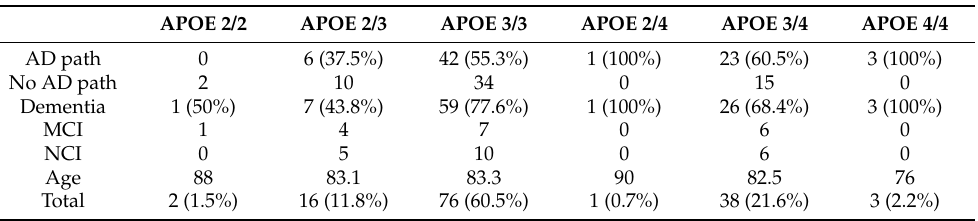
Table 3. Clinical and AD pathology diagnosis within each APOE genotype in the 136 MSBB subjects used in the transcriptomic